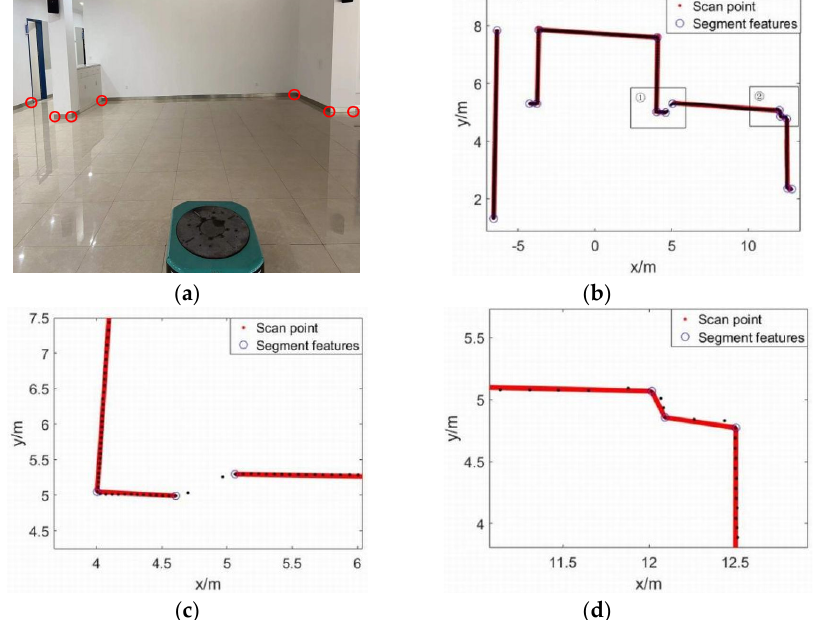
Figure 8. Line segment feature extraction example: ( a ) corridor environment; ( b ) overall graph of line segment feature extraction; ( c ) local amplification of region 1; ( d ) local amplification of region 2.